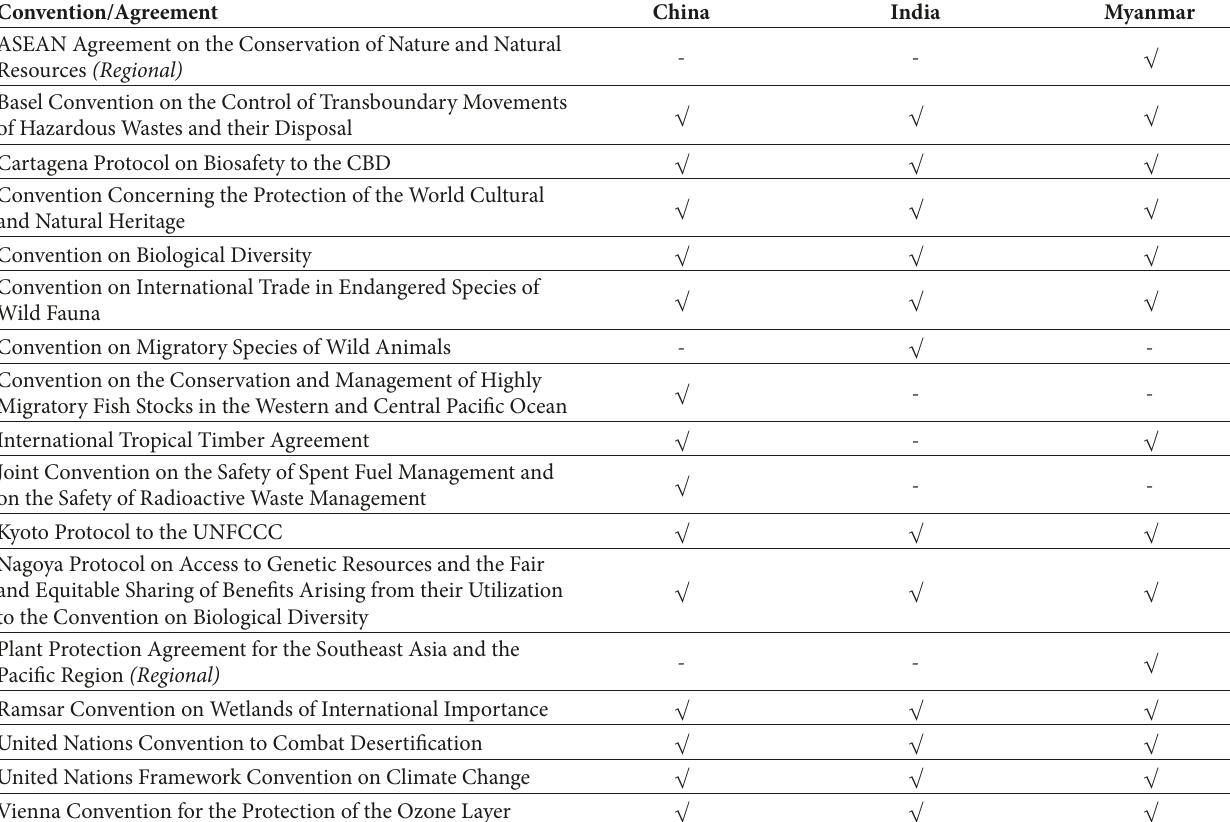
Table 3: International/regional environmental agreements, treaties and protocols ratified/accessioned by China, India &